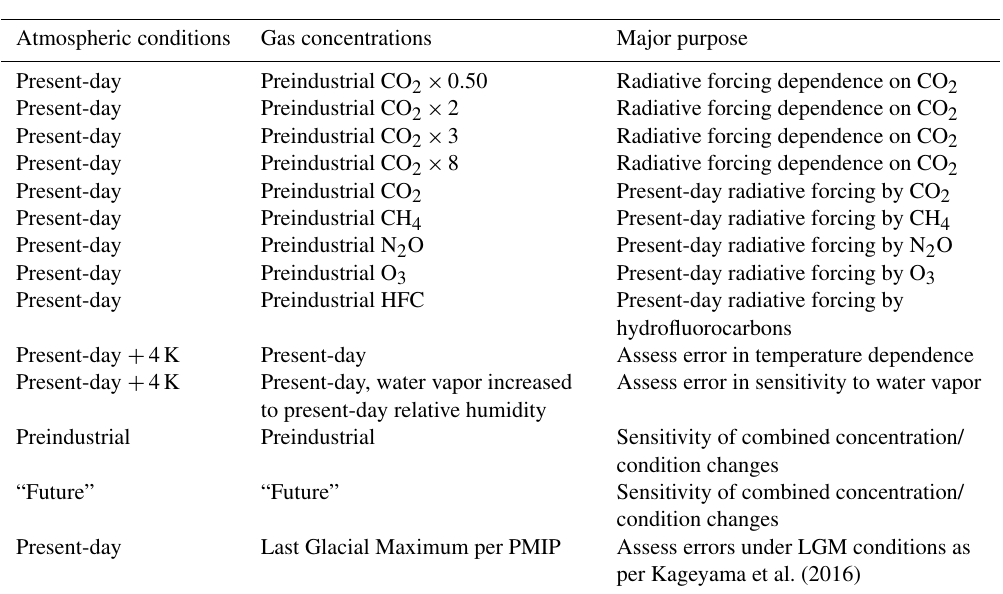
Table 4. Sets of atmospheric conditions to be supplied by RFMIP for assessing radiative forcing by specific agents and probing sources of parameterization error. The entire set of conditions is described as CMIP experiment RFMIP-IRF with CMIP6 Label (experiment_id)